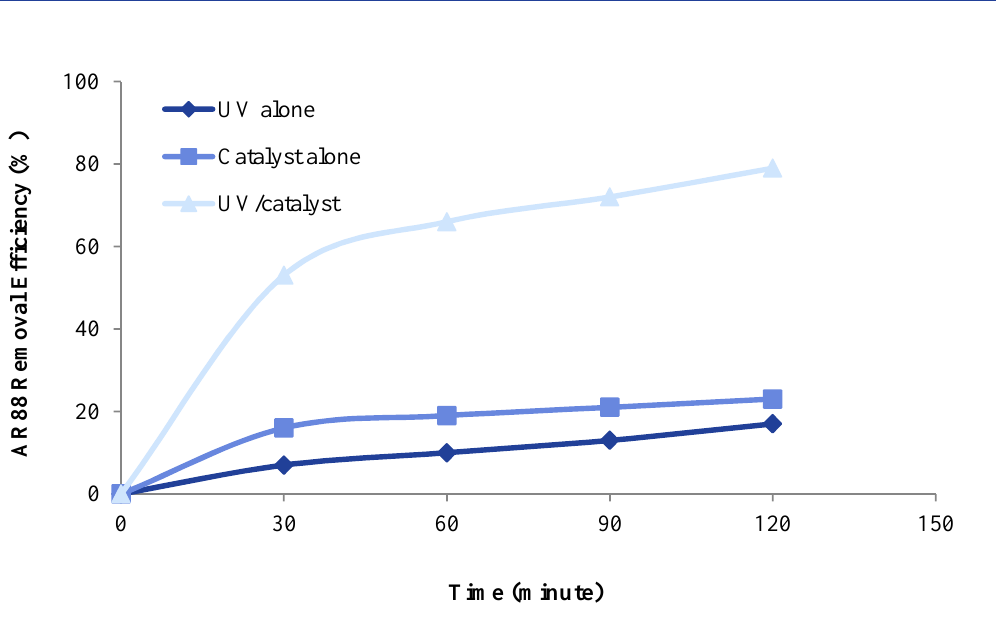
Figure 8. Comparison of photolysis, nanocatalyst alone, and photocatalysis processes in the removal of Acid Red 88 (AR88) from aqueous solutions (initial dye concentration: 50 mg/l, pH: 7, time: 120